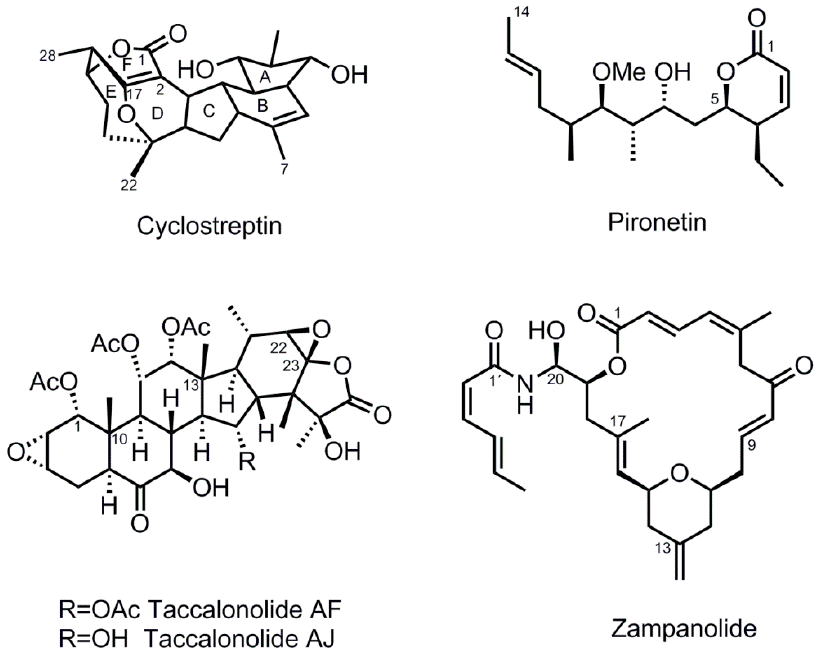
Figure 1. Chemical structures of covalent tubulin-binding compounds employed in this study.